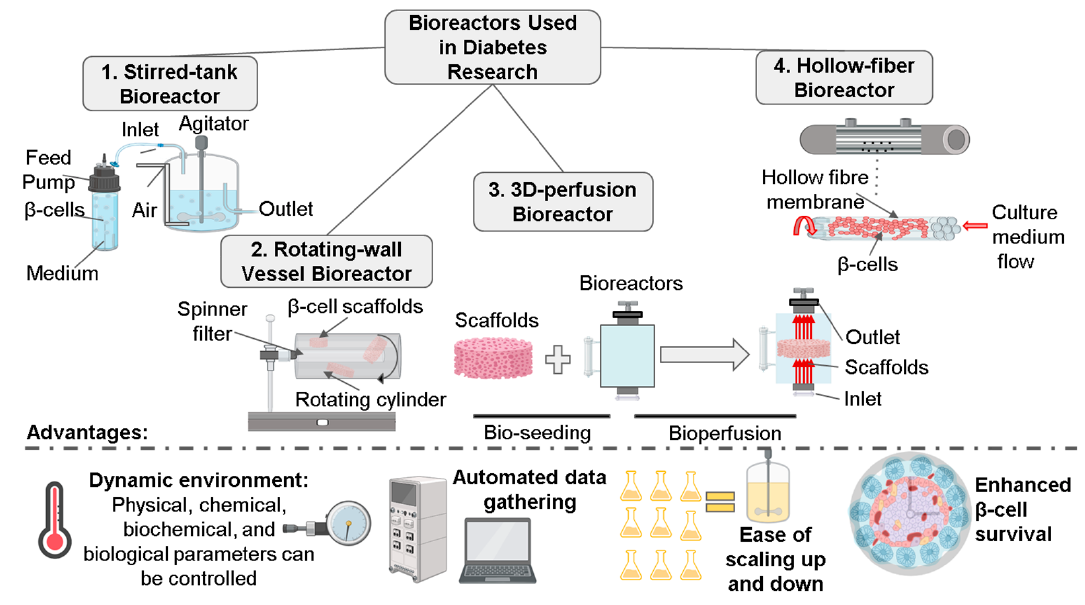
Figure 5. Various bioreactors in diabetic research: Bioreactors are capable of achieving effective cell expansion by assessing significant factors such as substrate consumption, metabolite synthesis, cell proliferation, and differentiation, and allow for high-precision control of critical parameters includ- ing pH, temperature, active fluid flow supply, and gas supply. Four types of bioreactors have been commonly employed including (1) stirred-tank bioreactors (2) rotating-wall vessel bioreactors (3) 3D-perfusion bioreactors, and (4) hollow-fiber bioreactors. β -cells grown in stirred tank bioreactors exhibited excellent viability and synthesized more insulin in comparison with aggregate suspension culture. The rotating-wall bioreactors provided the advantage of appropriate mixing, which ensures nutrition and oxygen transport to cells. Multicompartment 3D-perfusion bioreactors exhibited re- producible metabolic activity. Hollow-fiber bioreactors facilitate uniform nutrition and gas ex- change with greater physiological gradients, integrated oxygenation, and pH control to the total cell compartment volume with minimal shear stress.